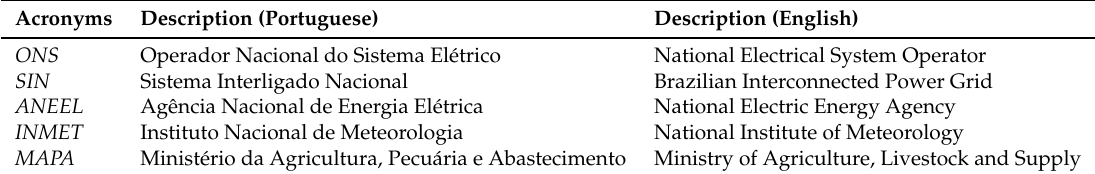
Table 1. List of abbreviations for Brazilian agencies.